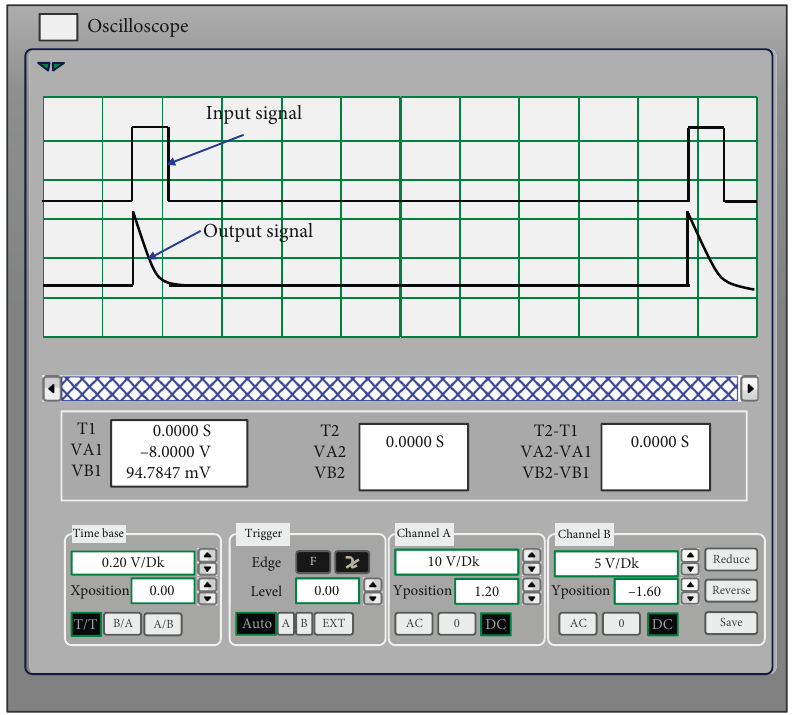
Figure 3: Simulation results of negative exponential signals at C